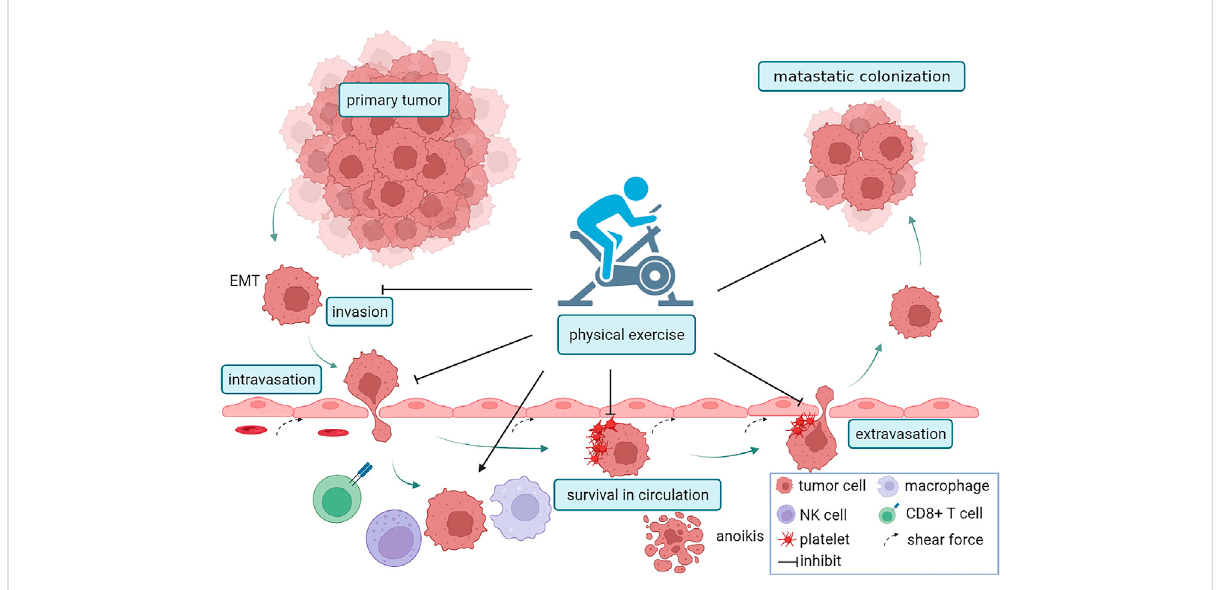
PAandthemetastaticcascade.Firstly,PAreducedtheinvasionoftumorcellsbyinhibitingEMT.Next,PAreducedvascularpermeability,inhibitd the interaction between endothelial cells and tumor cells, and suppressed intravasation. Exercise can also inhibit the survival of circulating tumor cells (CTCs) by increasing vascular shear force, recruiting macrophages, NK cells, and CD8+T cells, regulating metabolism and inducing anoikis. Exercise inhibitd platelet-tumor cells aggregates and the capacity of tumor cells to adhere to endothelial cells, which suppress extravasation. The fi gure was created with